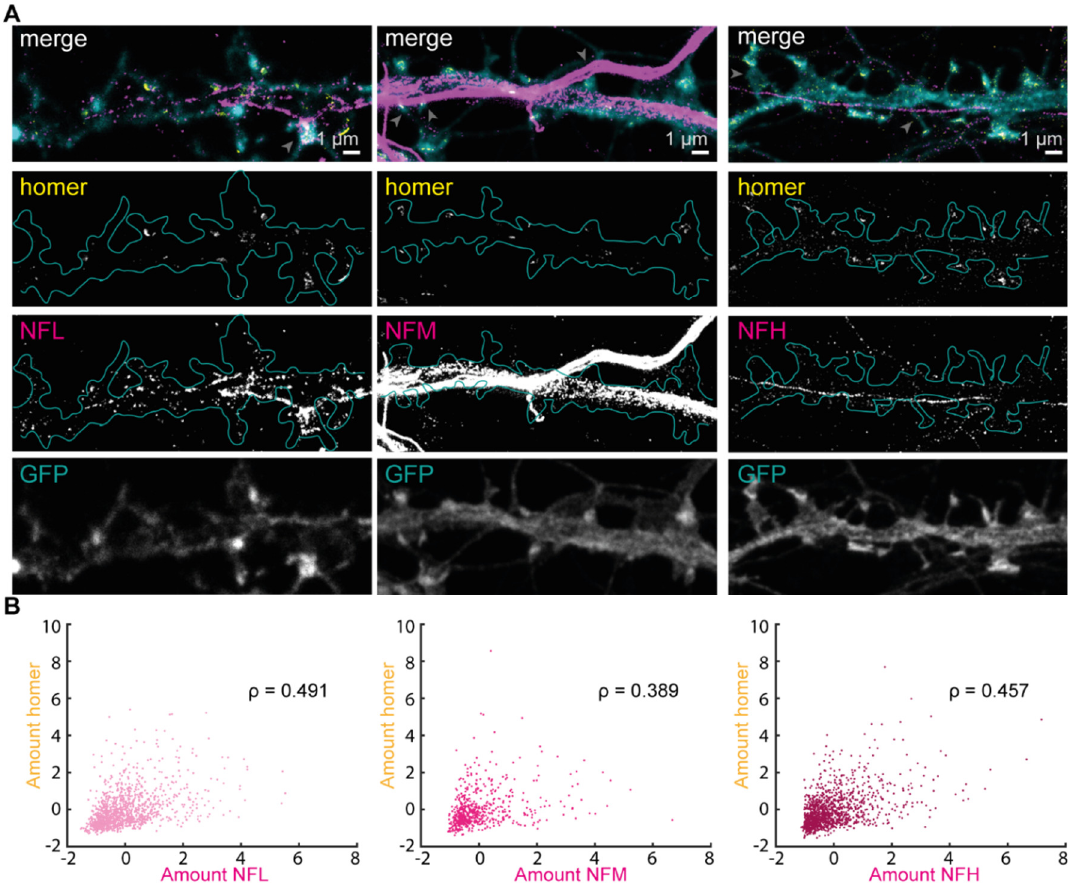
Figure 3. Positive correlation between NFs at the postsynapse and postsynaptic strength. ( A ) Representative dual-color STED images of neurons with homer (yellow), NFs (magenta), and volume labeling (confocal, cyan) with NFL (left), NFM (middle), or NFH (right). Cyan outline represents spine shapes on the dendrite as determined by volume labeling. Scale bars are 1 µm. Only signal above the 4-counts threshold used for data analysis is shown. Gray arrows in merge images point at examples of spines that were not considered for the analysis due to the overlay of strong axonal signal. ( B ) Scatterplot of NF versus homer protein amount ( area × mean intensity ). ρ indicates Spearman’s correlation coefficient with p values for NFL: 1.124 × 10 −72 ; NFM: 3.564 × 10 −24 and NFH: 4.202 × 10 −61 . Data was obtained from 3243 manually segmented spines (1248, 809, and 1186 for NFL, NFM and NFH, respectively) from 19–21 images per isoform and 6 independent neuronal cultures (14–21 DIV), standardized to the mean of each experiment. Amounts represent arbitrary units.